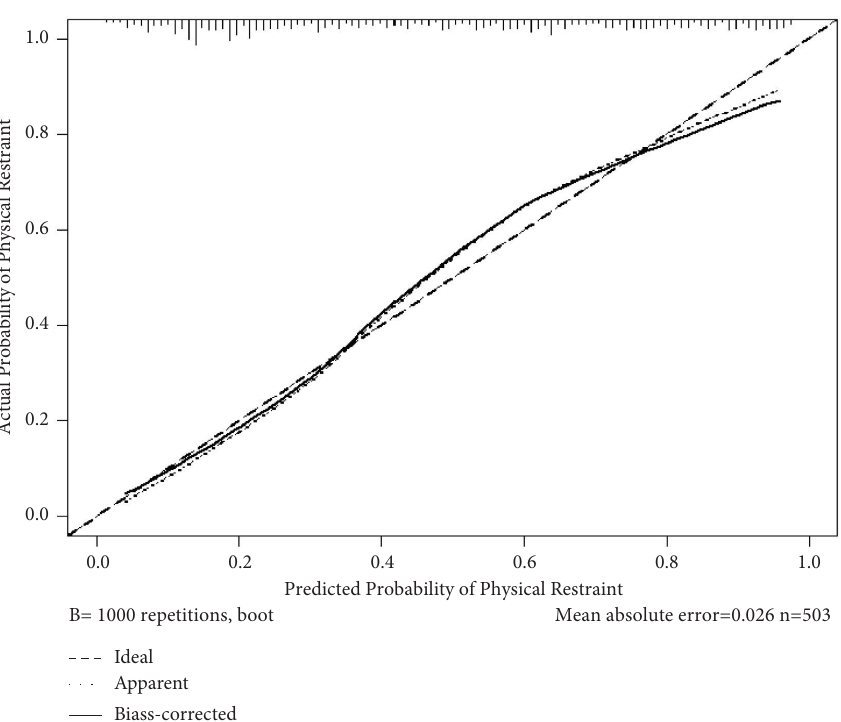
Figure 2: Calibration curves of the nomogram. It showed that the predicted probabilities by the nomogram ftted extremely well with the actual